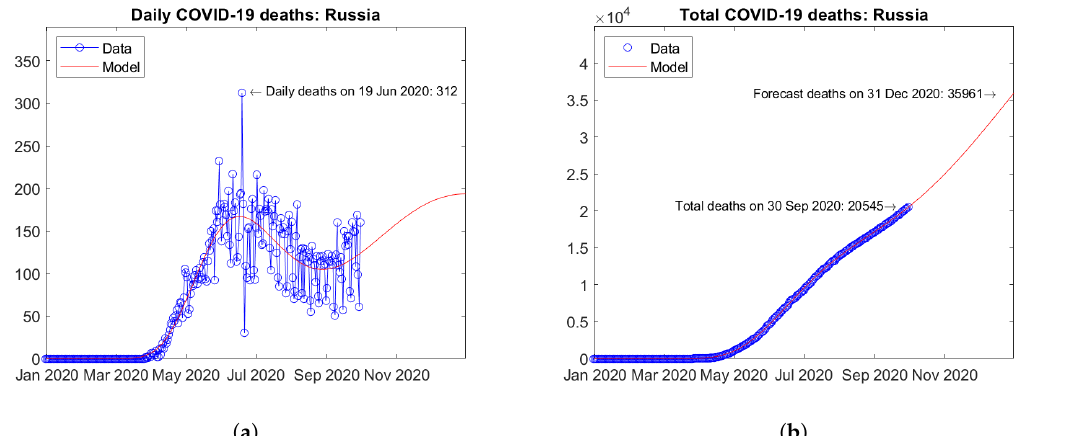
Figure 15. Actual and predicted trends in Russia: ( a ) daily deaths, ( b ) total